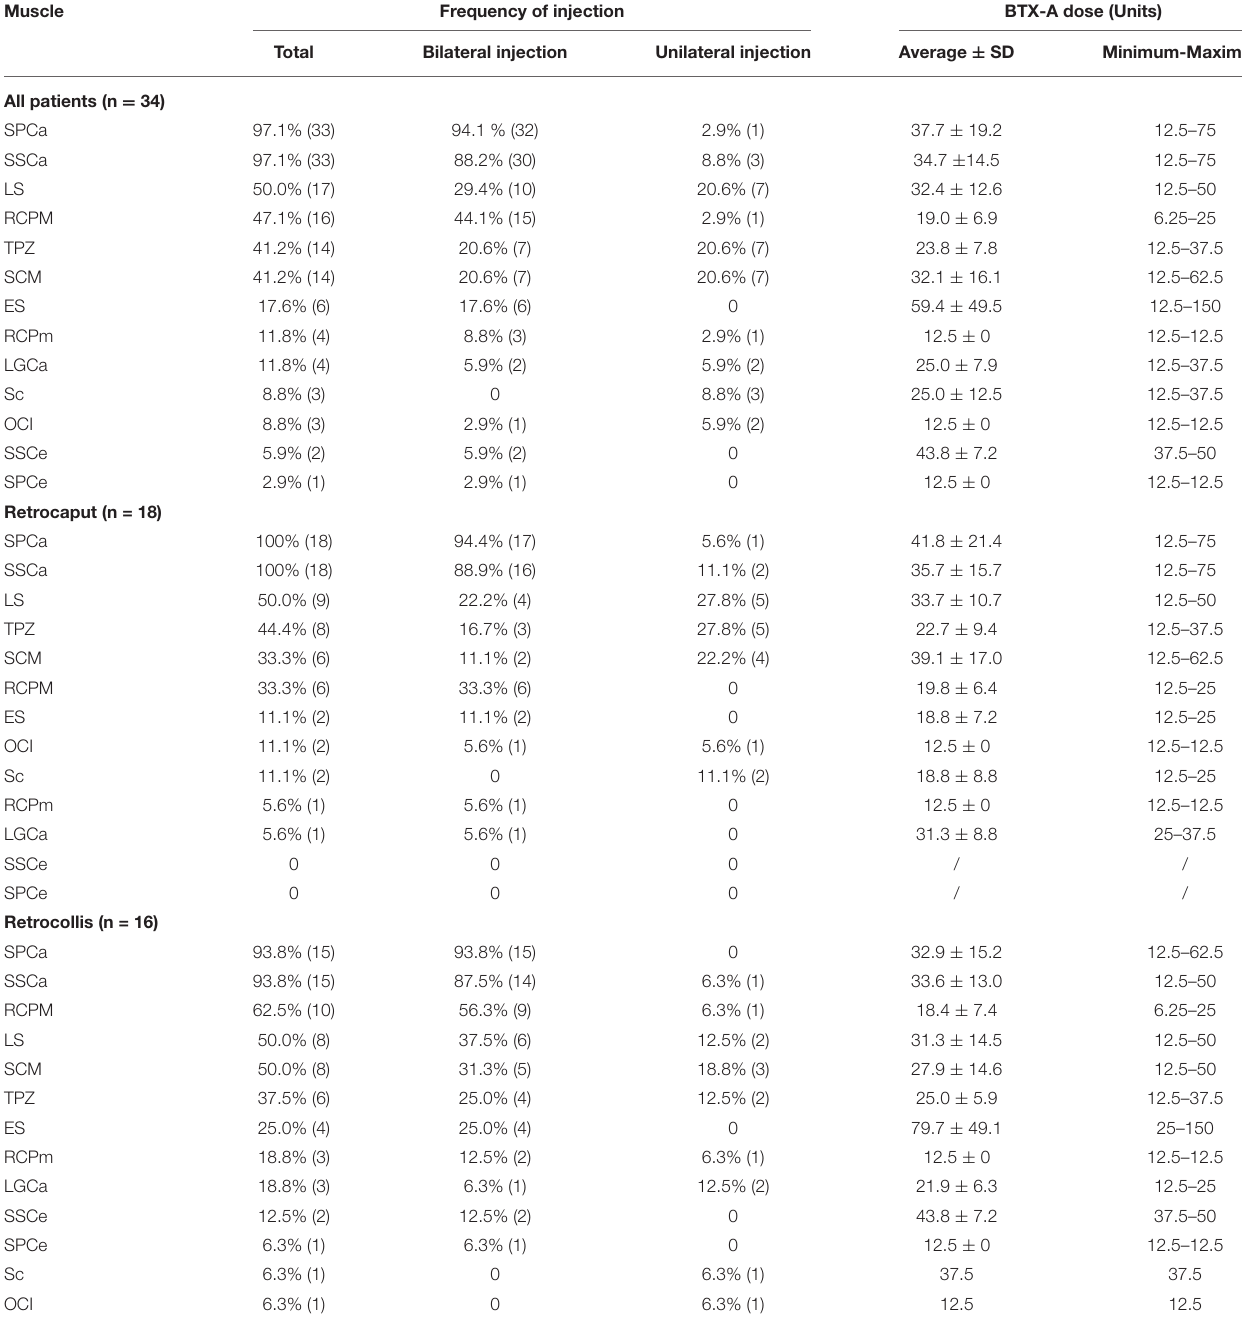
TABLE 2 | Frequency of injection and BTX-A dose for each cervical muscle.